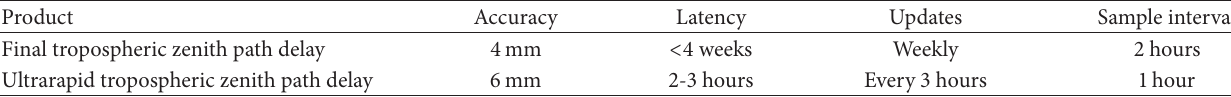
Table 2: IGS tropospheric products (http://igscb.jpl.nasa.gov/components/prods.html, assessed 20/02/14).